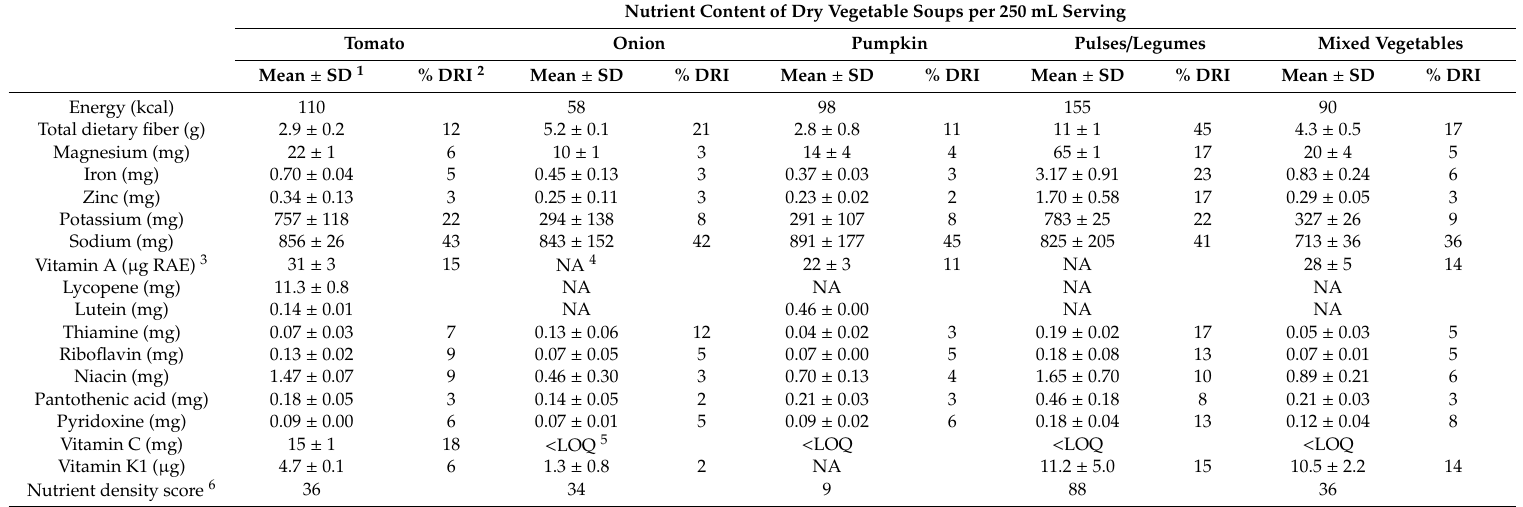
Table 3. Mean nutrient content and nutrient density scores of dry vegetable